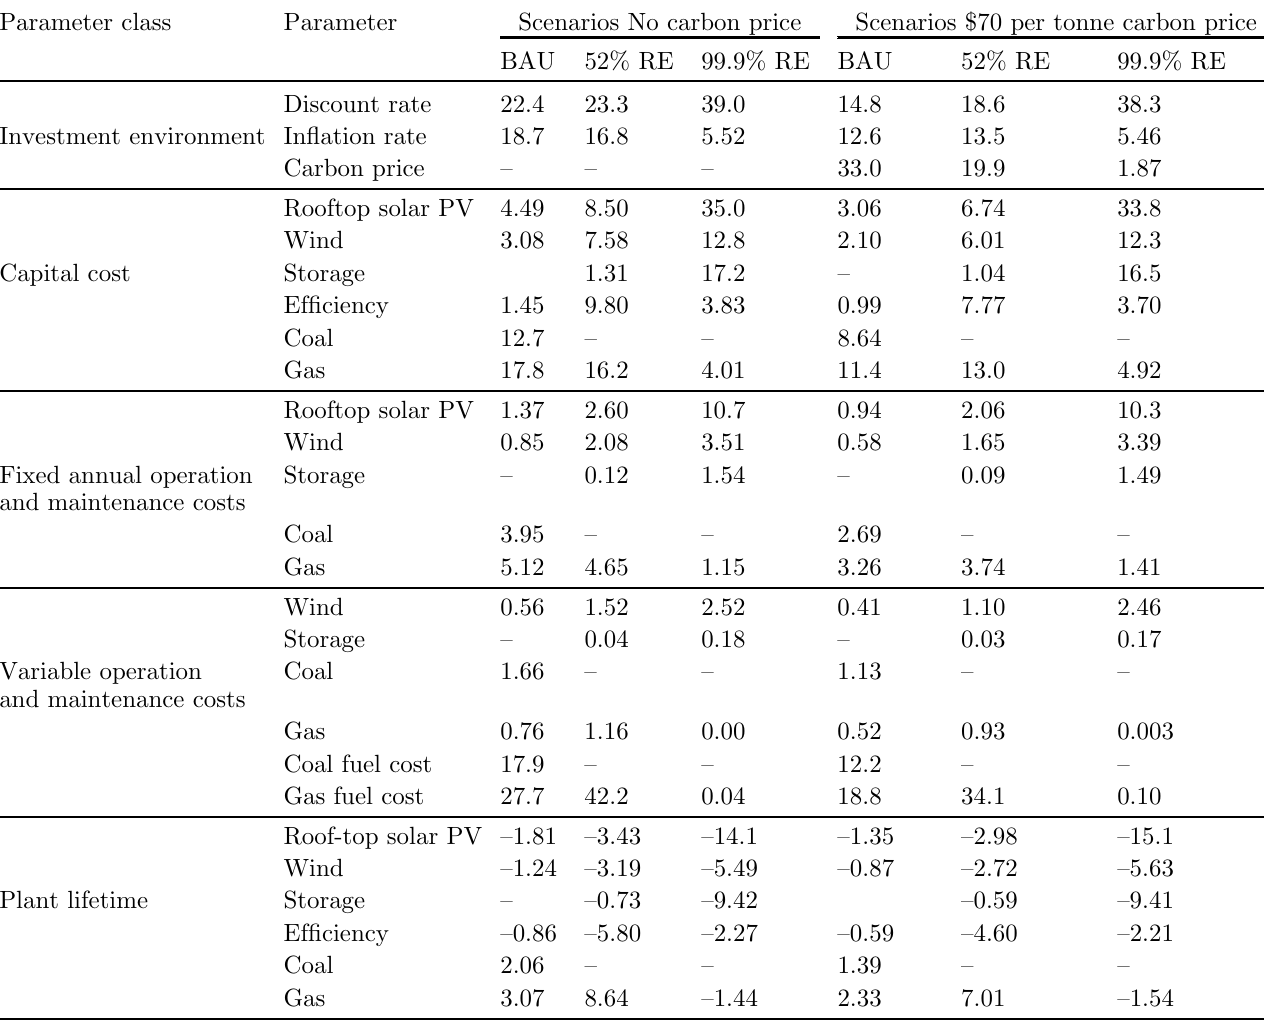
Table 13. Sensitivity of scenario cost to parameters.